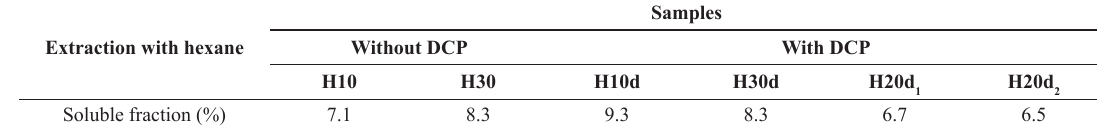
Extraction with hexane